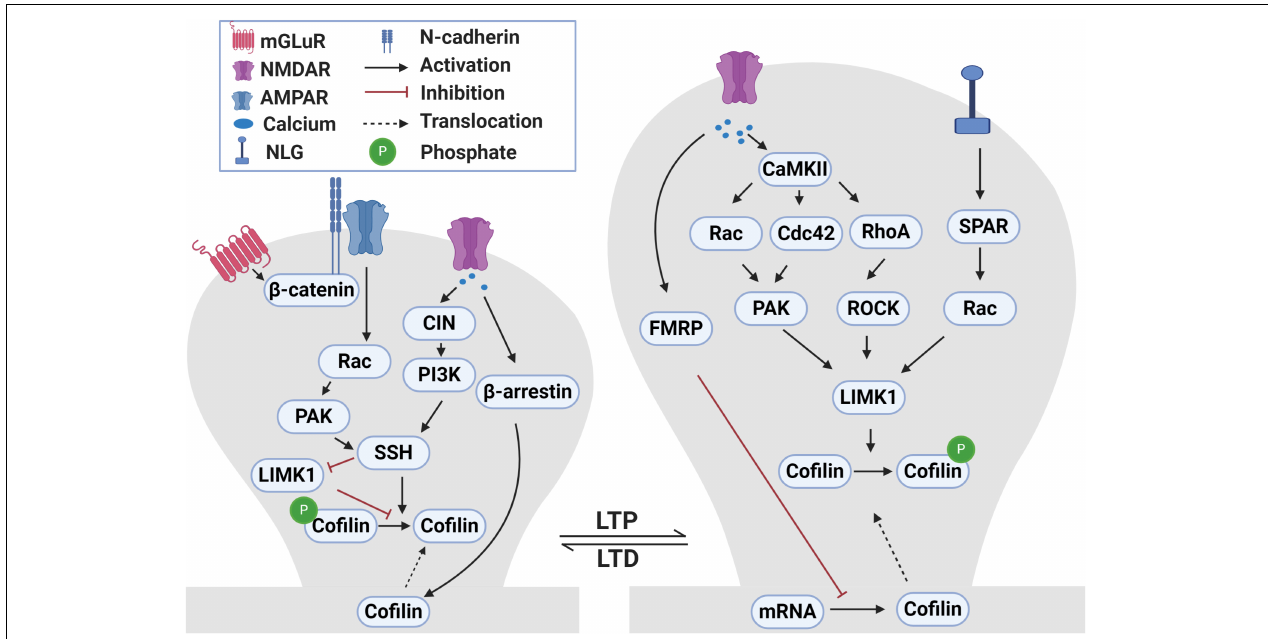
FIGURE 2 | Signaling pathways that regulate ADF/cofilin phosphorylation and dephosphorylation during LTP and LTD. During LTP, activation of NMDA receptors causes calcium influx into dendritic spines. The increased intracellular calcium activates CaMKII which in turn activates small Rho GTPases, including Rac, Cdc42 and RhoA. These small GTPases bind to and activate PAKs and ROCKs that can directly phosphorylate and activate LIMK1. LIMK1 can also be activated following the activation of neuroligin 1 receptors during LTP through SPAR-Rac signaling pathway. Activated LIMK1 phosphorylates and inactivates cofilin resulting in the enlargement of dendritic spines. In addition, the LTP-induced calcium influx diminishes local translation of cofilin mRNA in dendrites through a FRMP 1-dependent manner. Translocation of cofilin into spines during LTP occurs through yet to be discovered mechanisms. During LTD, the activation of NMDA receptors and influx of calcium activates CIN which activates SSH through the PI3K-dependent pathway. Activated SSH dephosphorylates and activates cofilin which results in dendritic spine shrinkage. In addition, LTD-induced calcium influx mediates translocation of cofilin into spines in a β -arrestin 2-dependent manner. During mGLuR-LTD, GluA2 interaction with cadherin/ β -catenin activates Rac-PAK which then activate SSH. Additionally, SSH can also dephosphorylate and inactivate LIMK1.